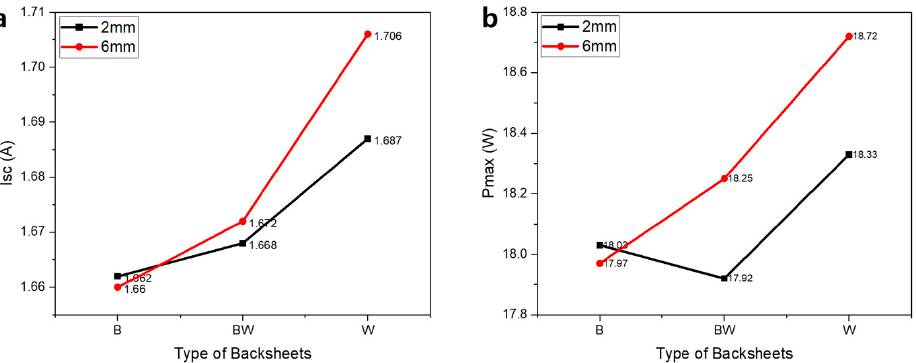
Figure 4. ( a ) The short-circuit current (I sc ) and ( b ) maximum power (P max ) of the shingled PV mod- ules with white, black, and W-B hybrid backsheets and various cell spaces (2 and 6 mm) .